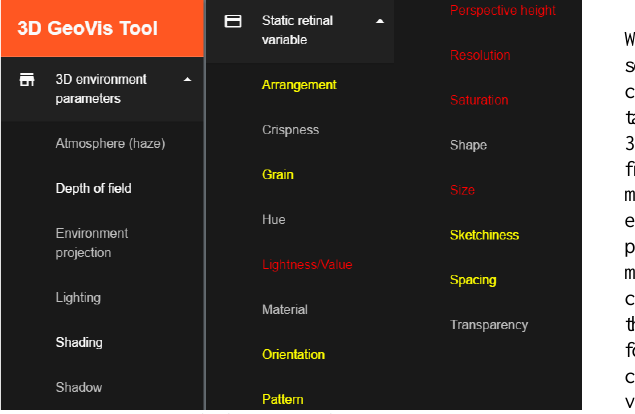
Figure 7 A proof-of-concept of decision support tool: Direct and Potential incompatibilities linked to the use of a